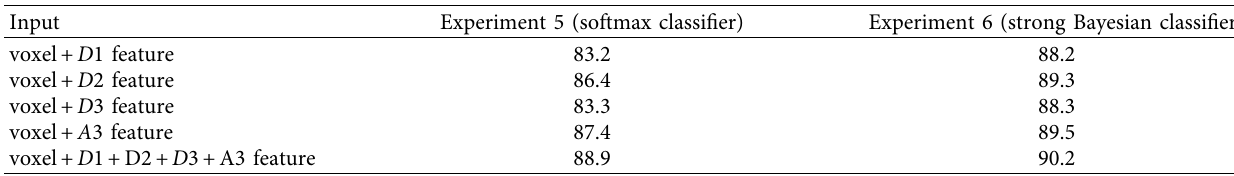
Table 3: Classification accuracy under voxel feature with different shape distribution features.